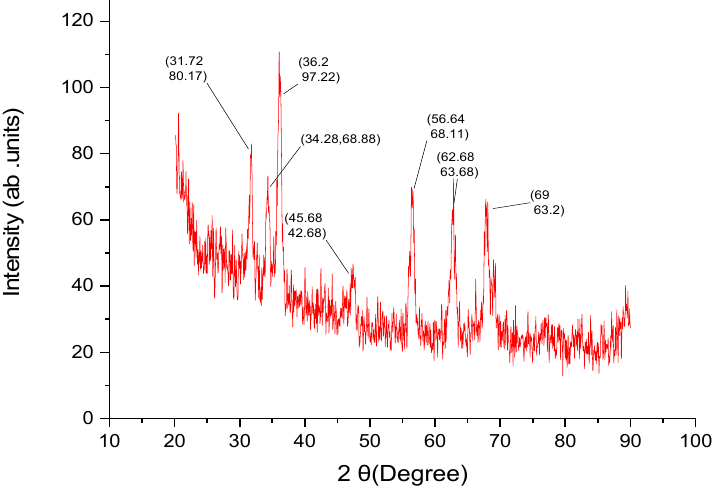
Figure 3. The XRD spectra of biosynthesized ZnO NPs from aqueous fraction of L. edodes